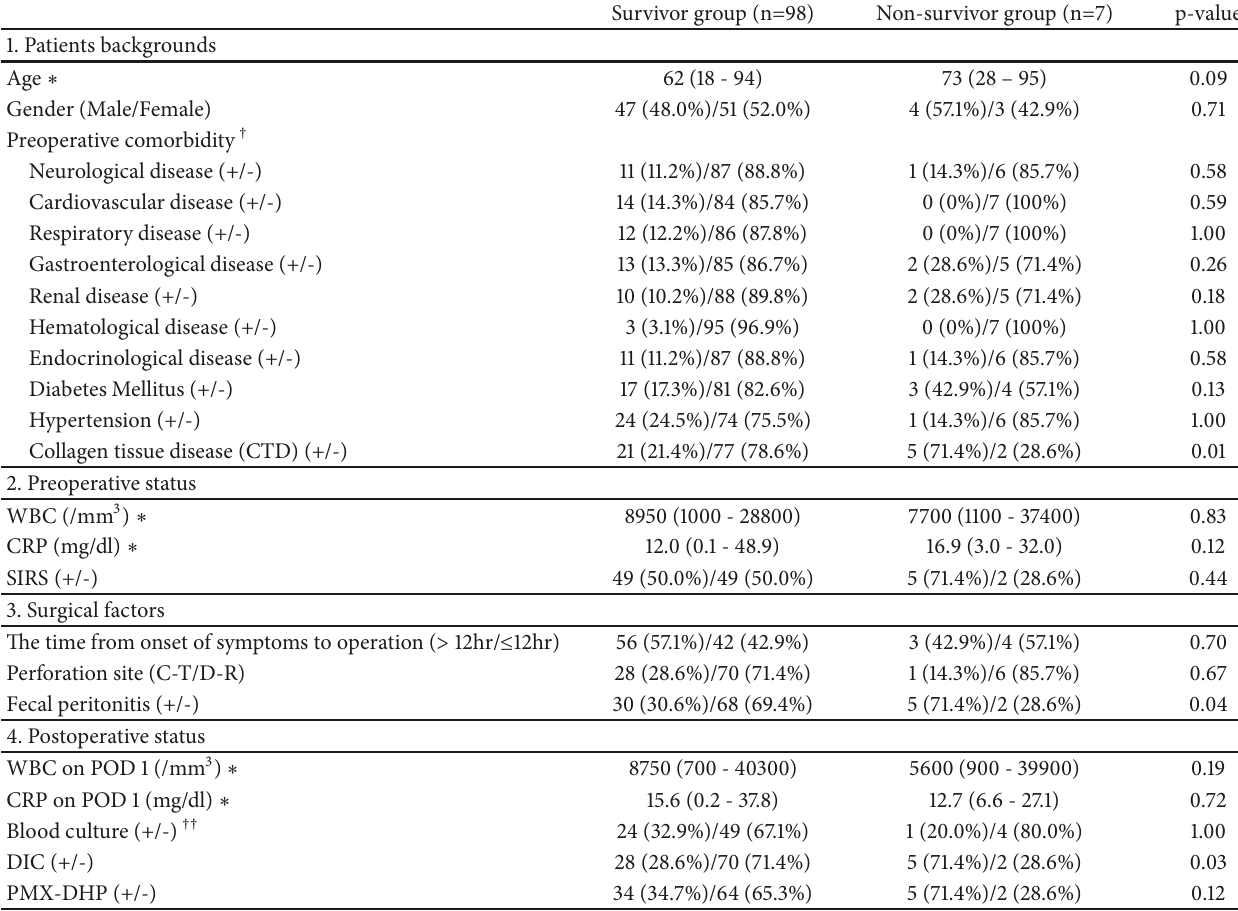
Table 1: Clinicopathological factors in survivors and non-survivors among all patients.